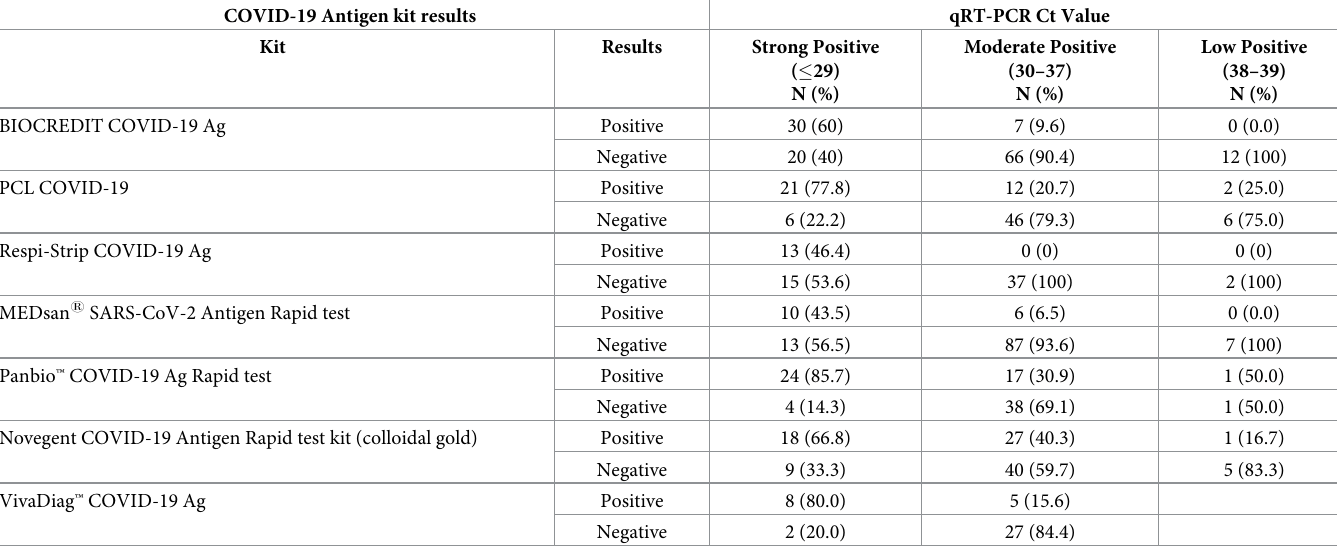
Table 3. COVID-19 Antigen Rapid test results compared to the Ct values on